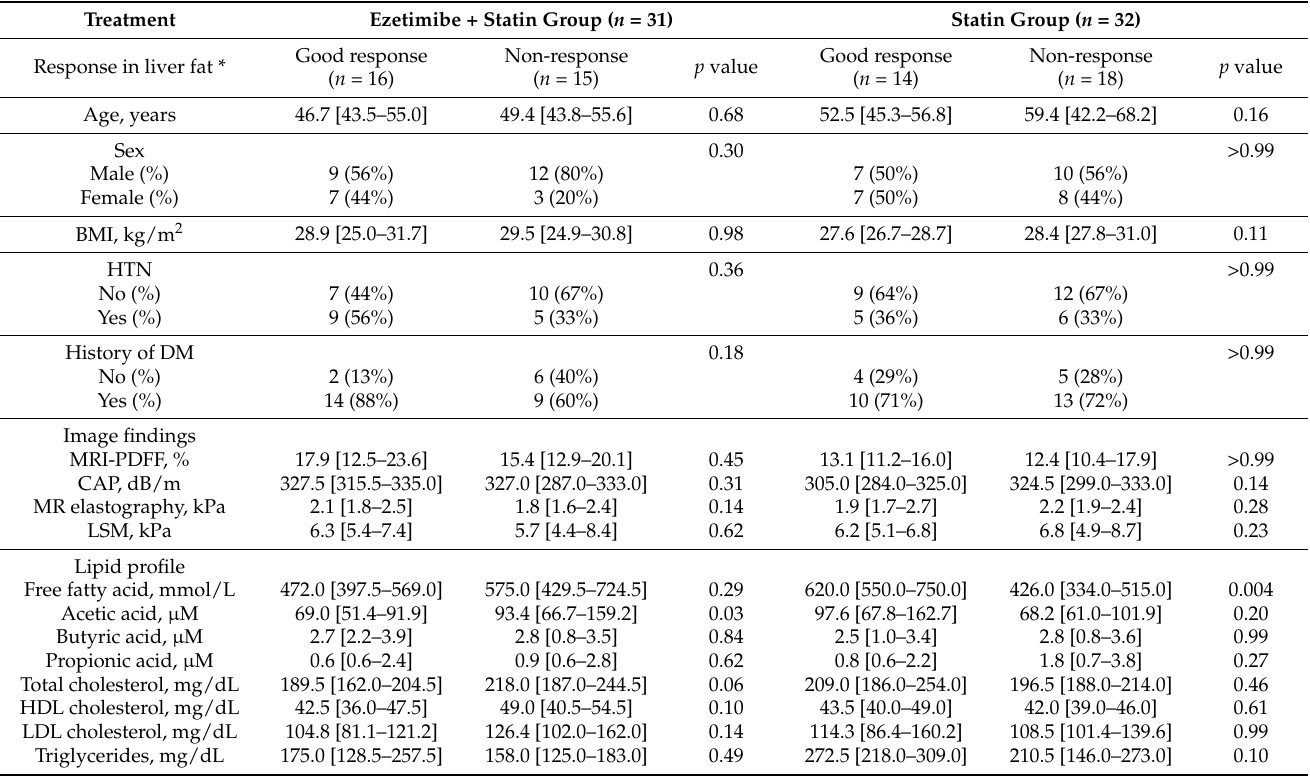
Table 1. Baseline demographic data and